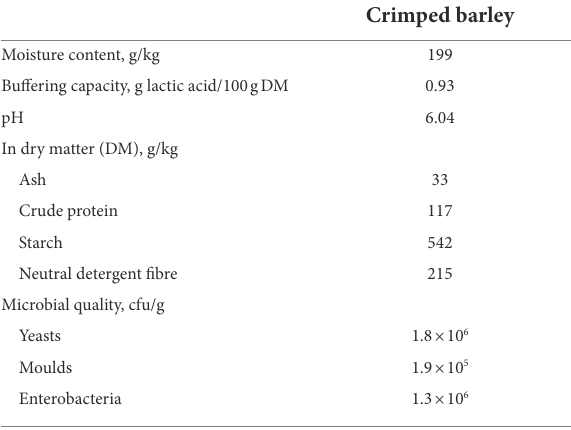
TABLE 1 Composition and microbial quality of crimped barley grain before